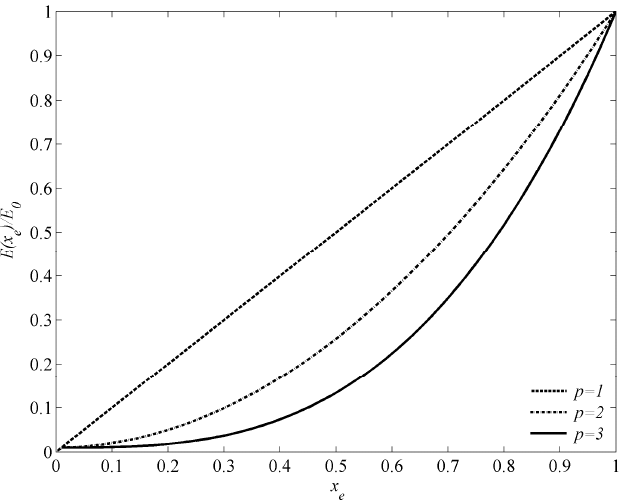
Figure 2. Material interpolation scheme with x min = 0.01.